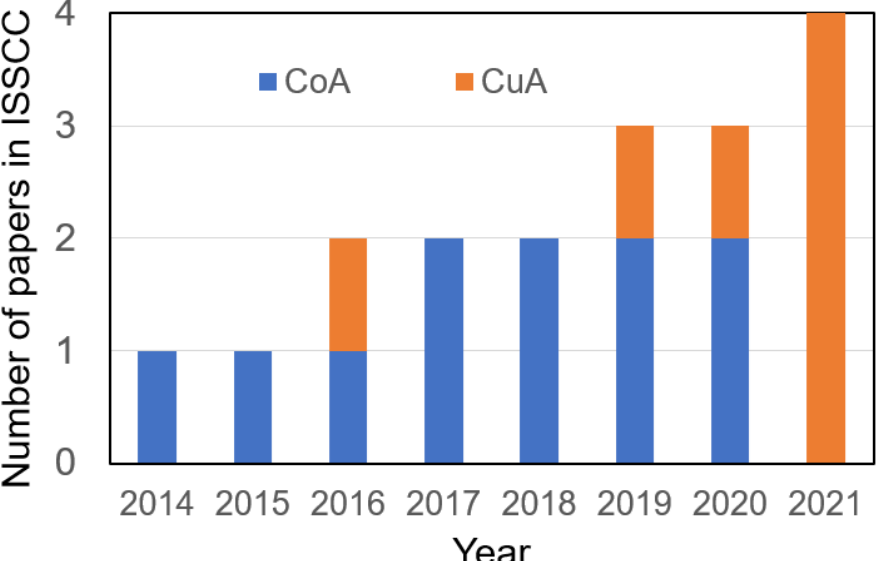
Figure 20. 3D NAND publications in ISSCC for CMOS outside array (CoA) and CMOS under array